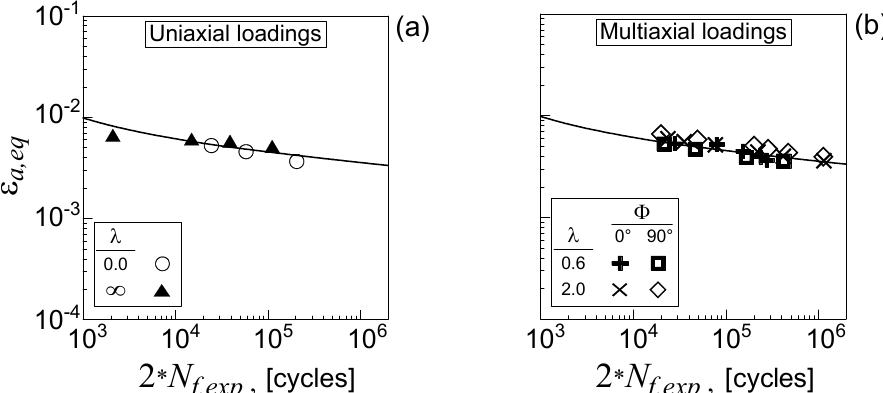
Figure 2: Fatigue life experimental data plotted in terms of the equivalent normal strain amplitude (Eq. (3)): (a) uniaxial loadings; (b) multiaxial loadings. The solid lines refer to the tensile Manson-Coffin